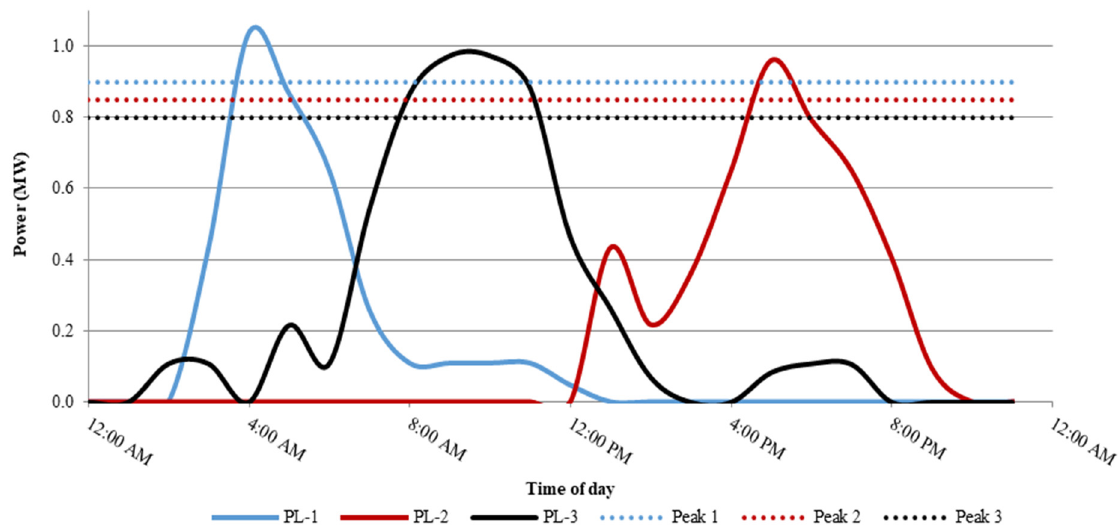
Figure 5. Power demand of each PL.